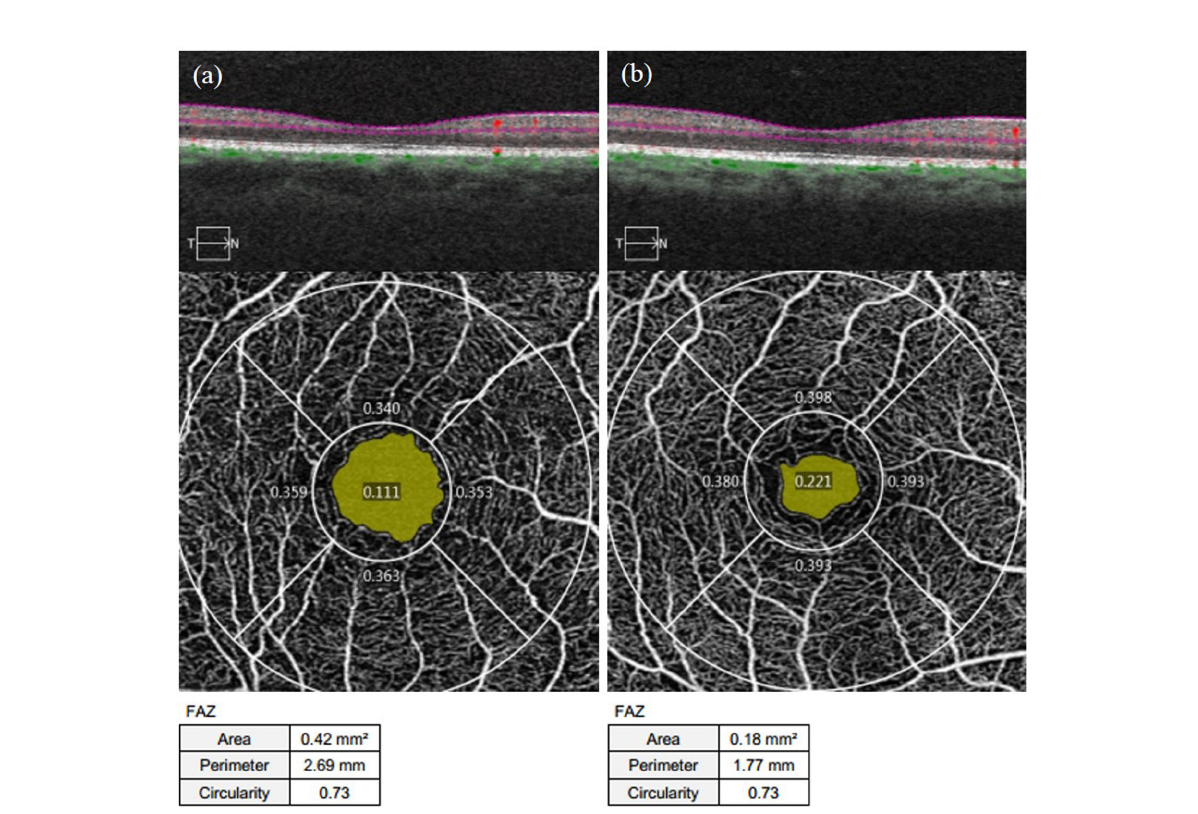
FIGURE 2 Representative OCTA images of the FAZ area, perimeter, and circularity measurements of the affected eyes in the NDR group and the tested eyes of the control group. (A) results of 3 mm×3 mm B scan of the OCTA in the macular area, super fi cial retinal en face images, and FAZ area, perimeter, and circularity that are automatically measured by the system software in the right eye of a 63-year-old female NDR patient. (B) results of 3 mm×3 mm B scan of the OCTA in the macular area, super fi cial retinal en face images, and FAZ area, perimeter, and circularity that are automatically measured by the system software in the right eye of a 54-year-old female control. The yellow area shows the FAZ area automatically identi fi ed by the system software. The FAZ area and perimeter of the affected eyes of the NDR patients were larger compared to the eyes of the control, and the FAZ circularity was equal. NDR, diabetes mellitus without diabetic retinopathy; FAZ, foveal avascular zone; OCTA, optical coherence tomography angiography.